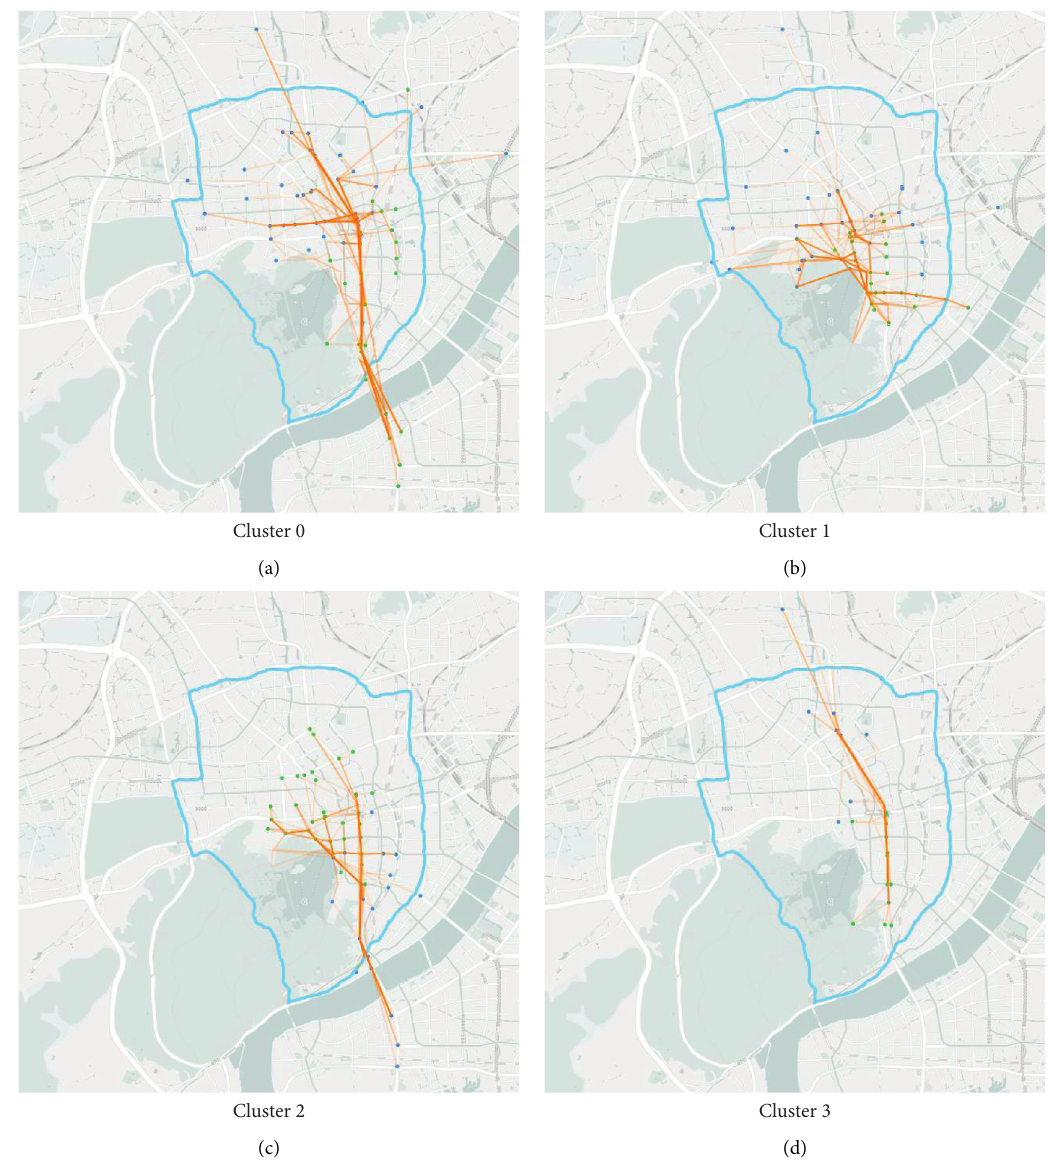
Figure 7: Visualization results of the first four clusters during the evening peak hours on June 15 based on the DBSCAN algorithm; the green point denotes the origin point, the blue point denotes the destination point, and the orange line denotes the trajectory. The darker the color of the line, the more the vehicles passing through the trajectory. Clusters are arranged in the descending order of the number of vehicles in them. (a) Cluster 0. (b) Cluster 1. (c) Cluster 2. (d) Cluster